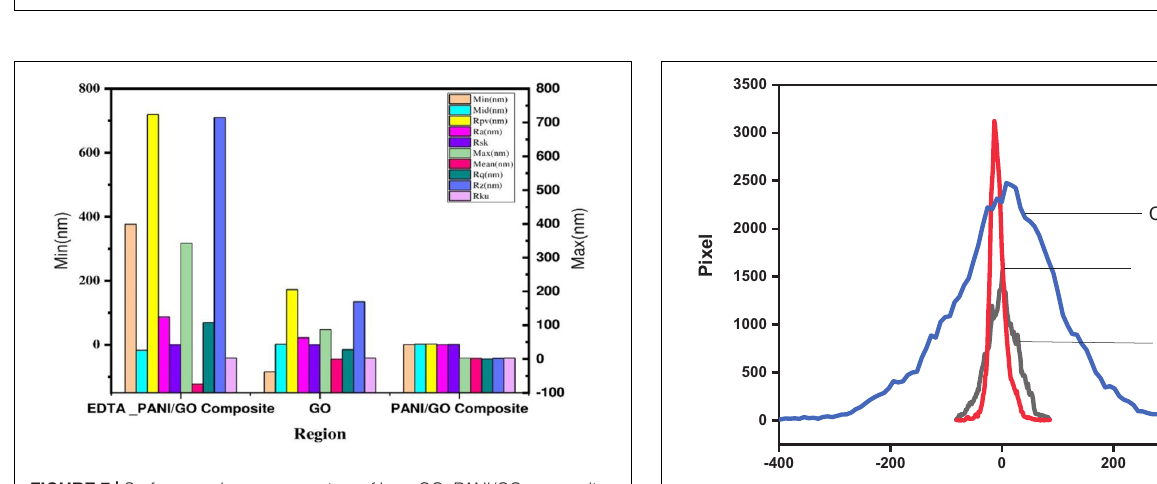
FIGURE 7 | Surface roughness parameters of bare GO, PANI/GO composite, and EDTA modified PANI/GO composite.